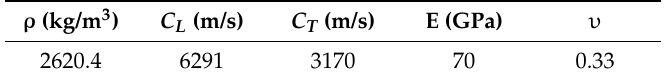
Table 2. Material properties of the plate model: Mass density ( ρ ), longitudinal wave velocity ( C L ), shear wave velocity ( C T ), Young’s modulus ( E ) and Poisson coefficient ( υ ).